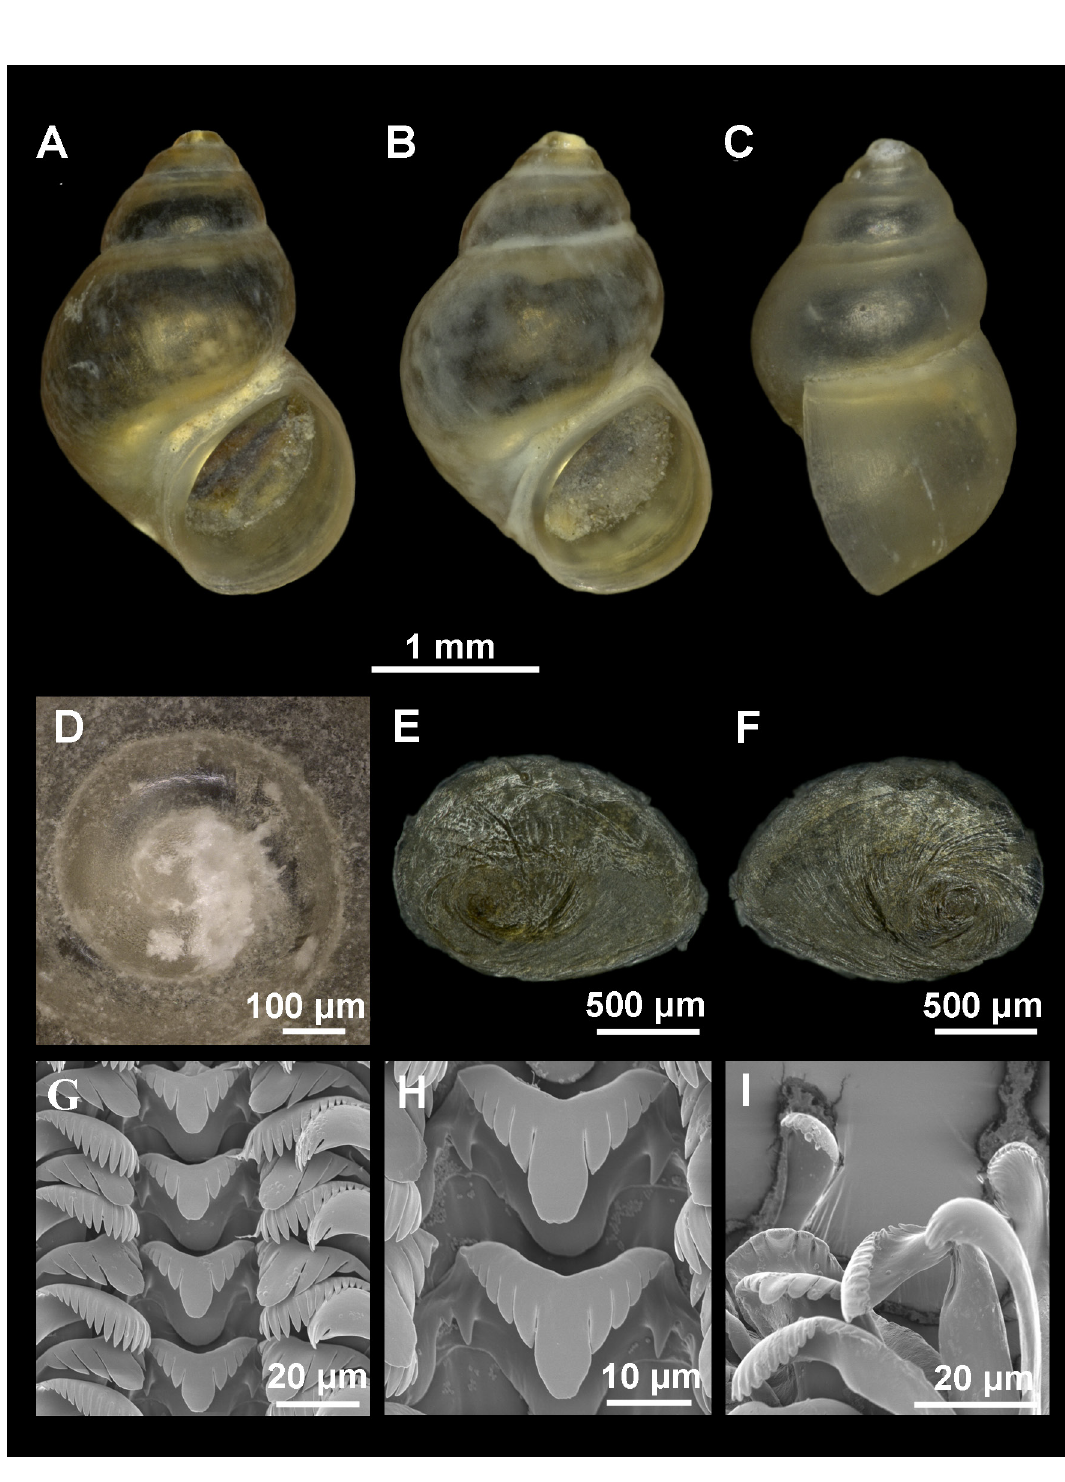
Fig. 6. Shell, operculum and radula of Persipyrgula saboori (Glöer & Pešić, 2009) gen. et comb. nov. from Zou Eram spring in Zou Eram village, Khorrasan Province, Iran. A–B . Shell in front view. C . Shell in lateral view. D . Protoconch and microsculpture. E–F . Internal and external side of the operculum. G . Rows of teeth of the radula. H . Central teeth. I . Detail of outer